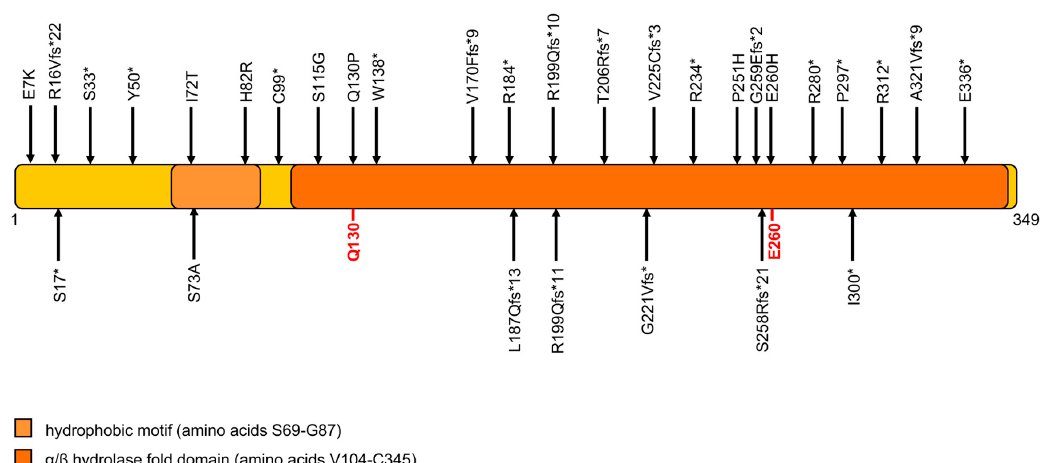
Figure 3. Domain organization of the α - β hydrolase domain 5 (ABHD5) protein, and variations associated with NLSD with ichthyosis (NLSDI). ABHD5 comprises 349 amino acids, characterized by an LD-binding site (hydrophobic domain) and an α / β hydrolase domain that includes two residues involved in ATGL and perilipin interaction (Q130 and E260). All ABHD5 mutations are shown based on recommendations for sequence variant description of HGVS-nomenclature website. Five